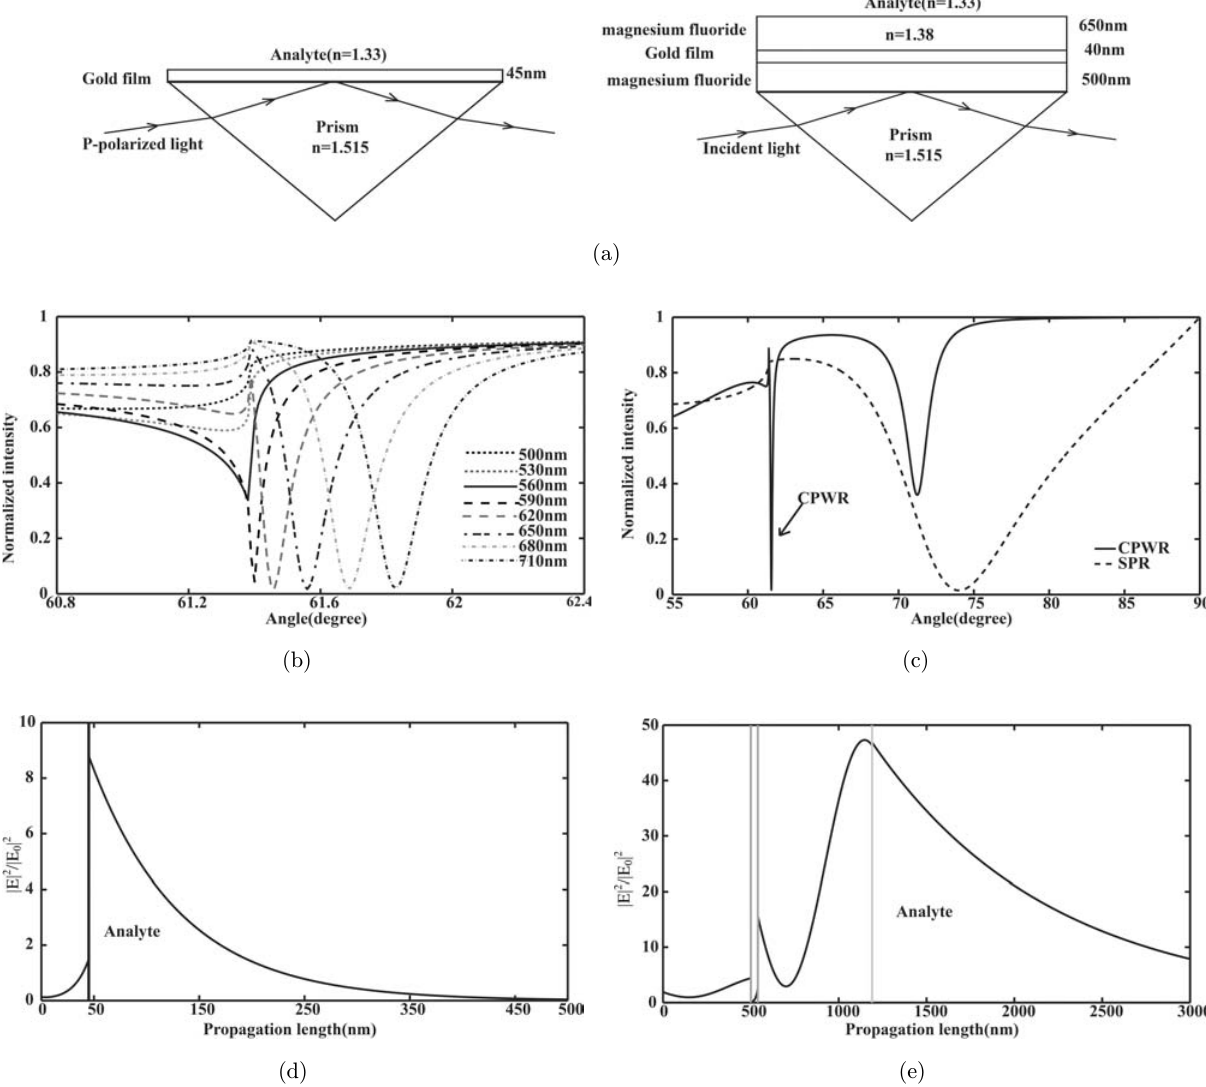
Fig. 1. 1D implementation of conventional SPR ((a) left) and the symmetrical CPWR ((a) right.) (b) Theoretically calculated CPWR under di®erent thicknesses of the waveguide layer. Theoretically calculated re°ective curves and electric ¯eld distributions excited by conventional SPR (dashed curve in (c), (d) and CPWR (solid curve in (c), (e))). The excitation wavelength is 632.8 nm. Refractive indices for the prism, analyte, magnesium °uoride and gold ¯lm are 1.515, 1.33, 1.38 and 0.3123 þ 3.146i individually.